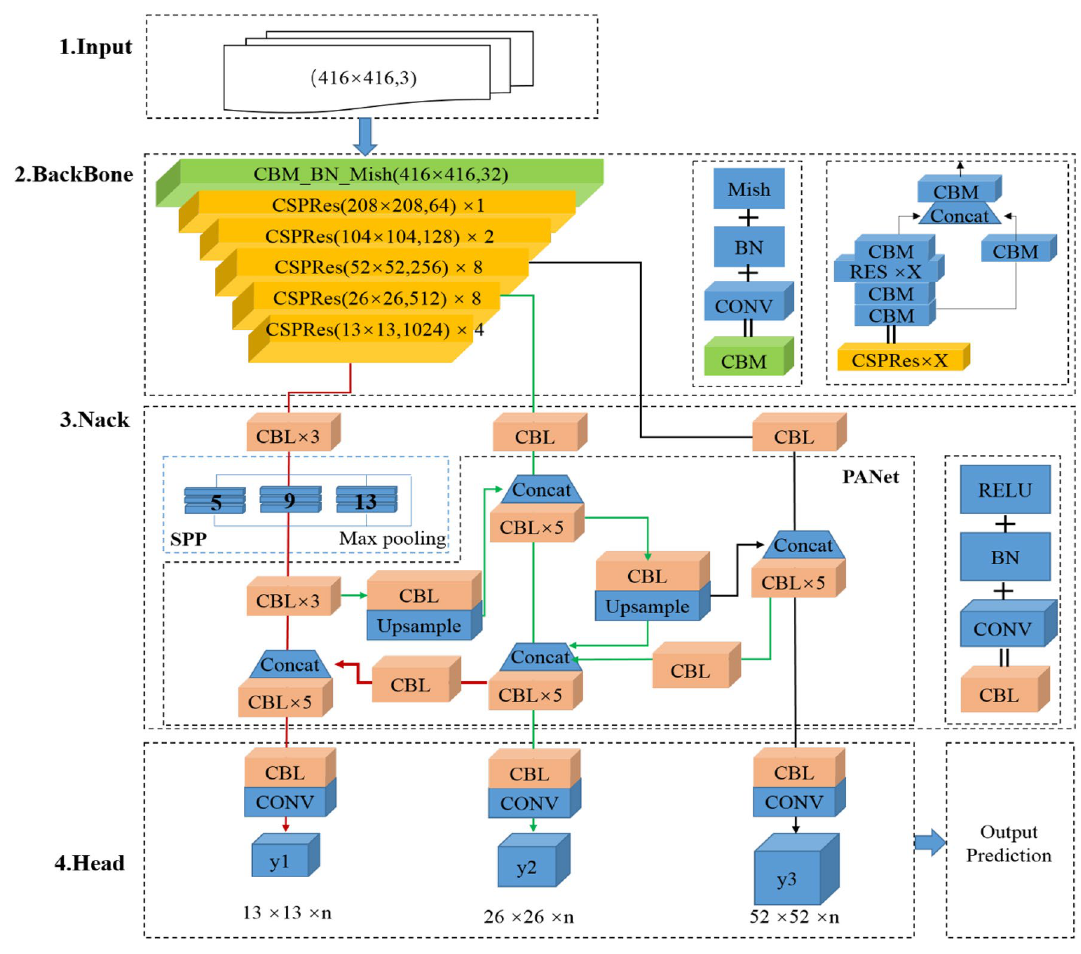
Figure 3. Yolov4 network